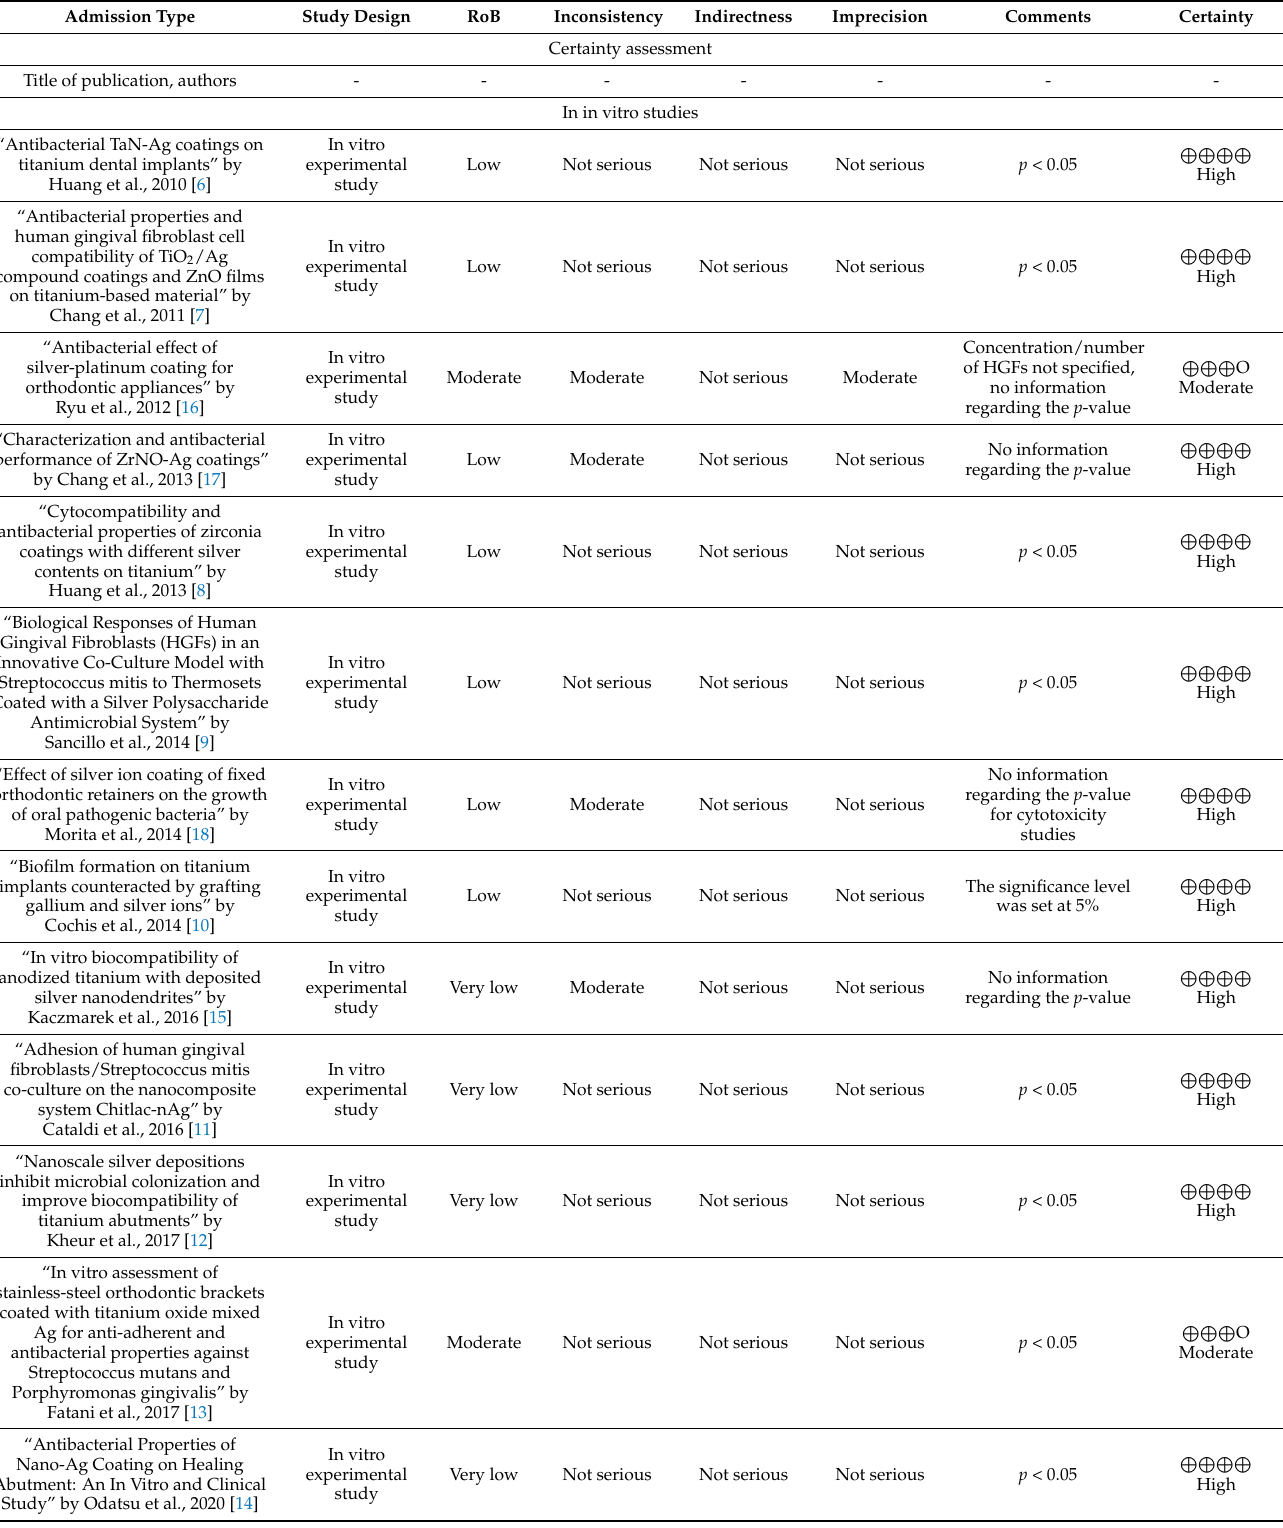
Table 2. The GRADE summary of